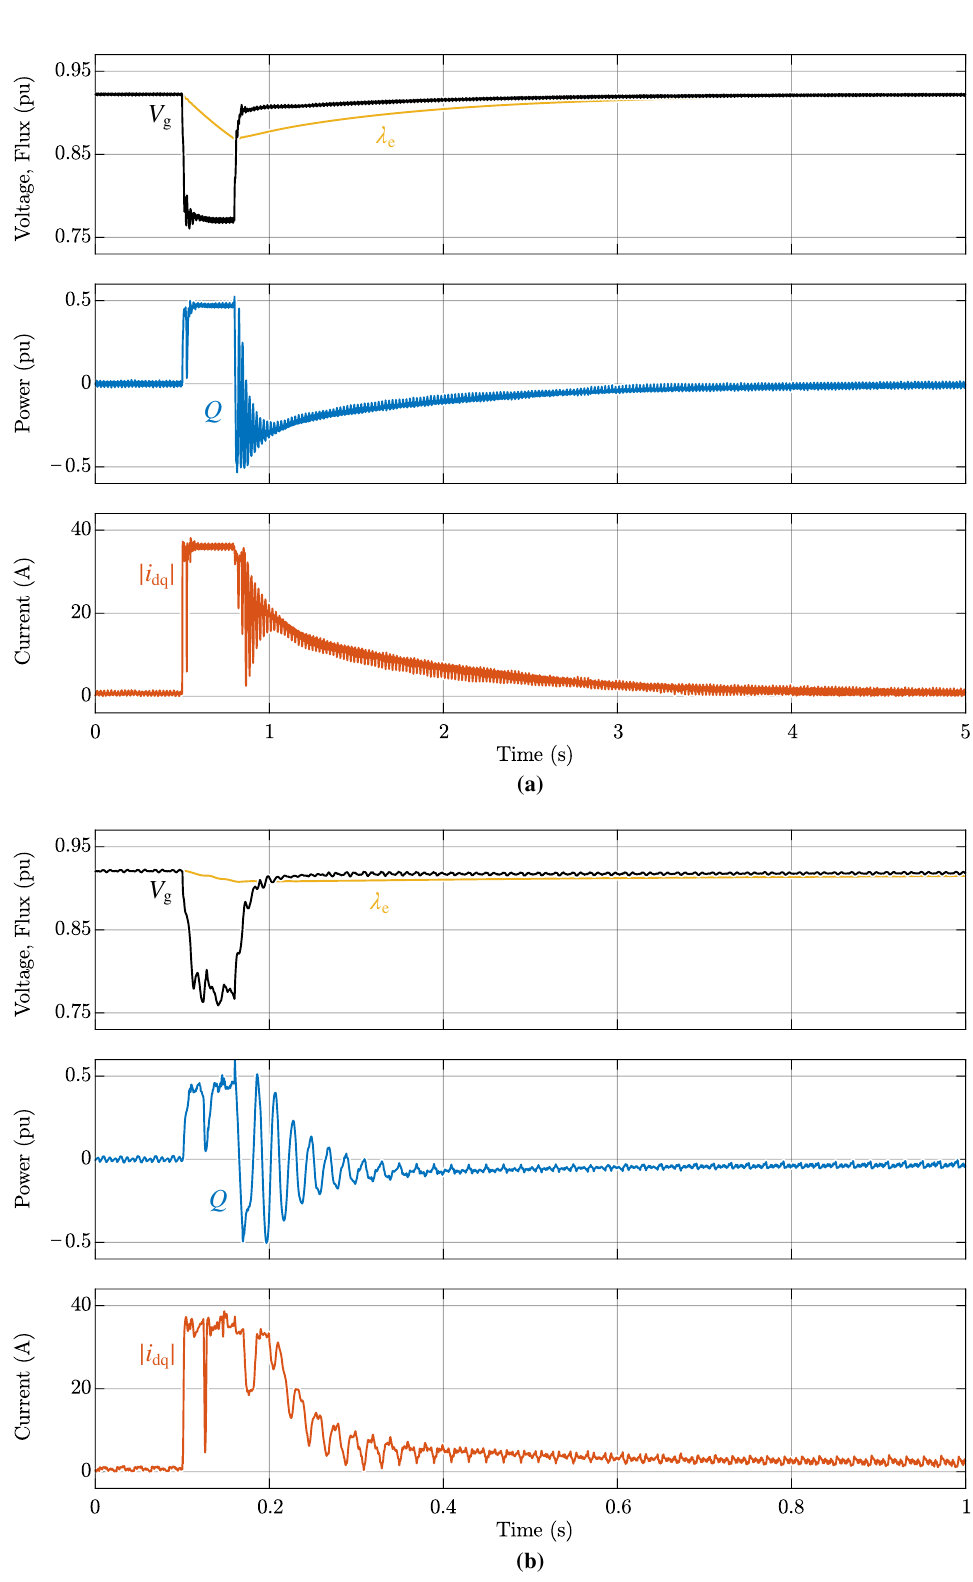
Figure 15. System response during Dip 1 ( a ) and Dip 2 ( b ), representative of a fault in the medium and high voltage grid, respectively. The S-VSC injects reactive current to support the grid voltage and trigger the protection relays.From top to bottom: ( top ) grid voltage amplitude V g and virtual excitation flux linkage λ e of the S-VSC; ( middle ) reactive power Q injected by the S-VSC into the grid; ( bottom ) amplitude of the current | i dq | injected by the S-VSC into the